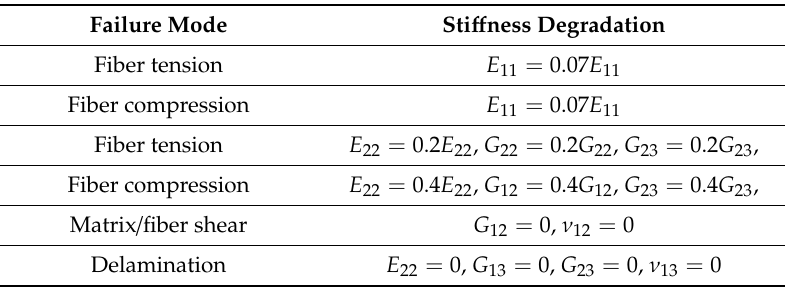
Table 3. Element stiffness degradation mode.